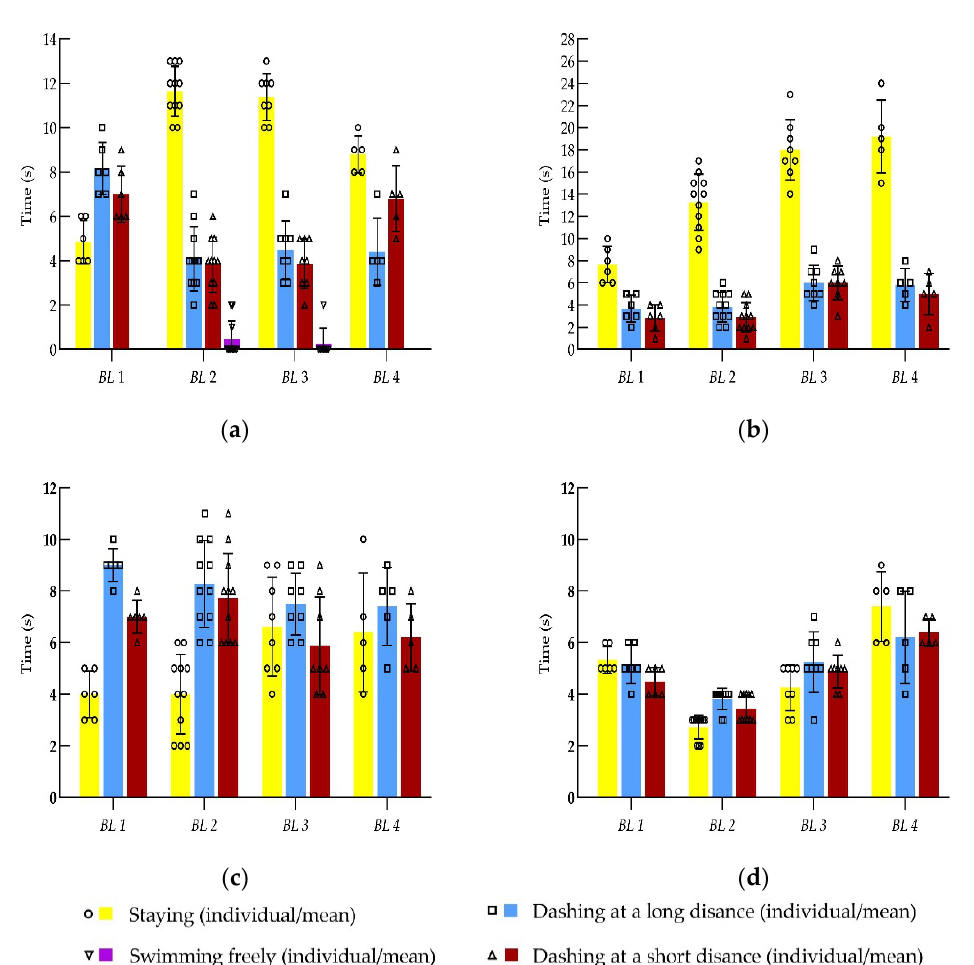
Figure 6. Time segment of fish swimming behaviors by size groups at various swimming stages: ( a ) Stage 1; ( b ) Stage 2; ( c ) Stage 3; ( d ) Stage 4. Note: the time segments (which are rounded to seconds) of individual fish swimming behaviors (staying, dashing at a long distance, swimming freely and dashing at a short distance) are represented by small circle, small square, and small triangles; the bar with the range represents the mean time ± standard deviation; the yellow, blue, red and purple bars represent the mean times of fish swimming behaviors of staying, dashing at a long distance, dashing at a short distance and swimming freely, respectively.